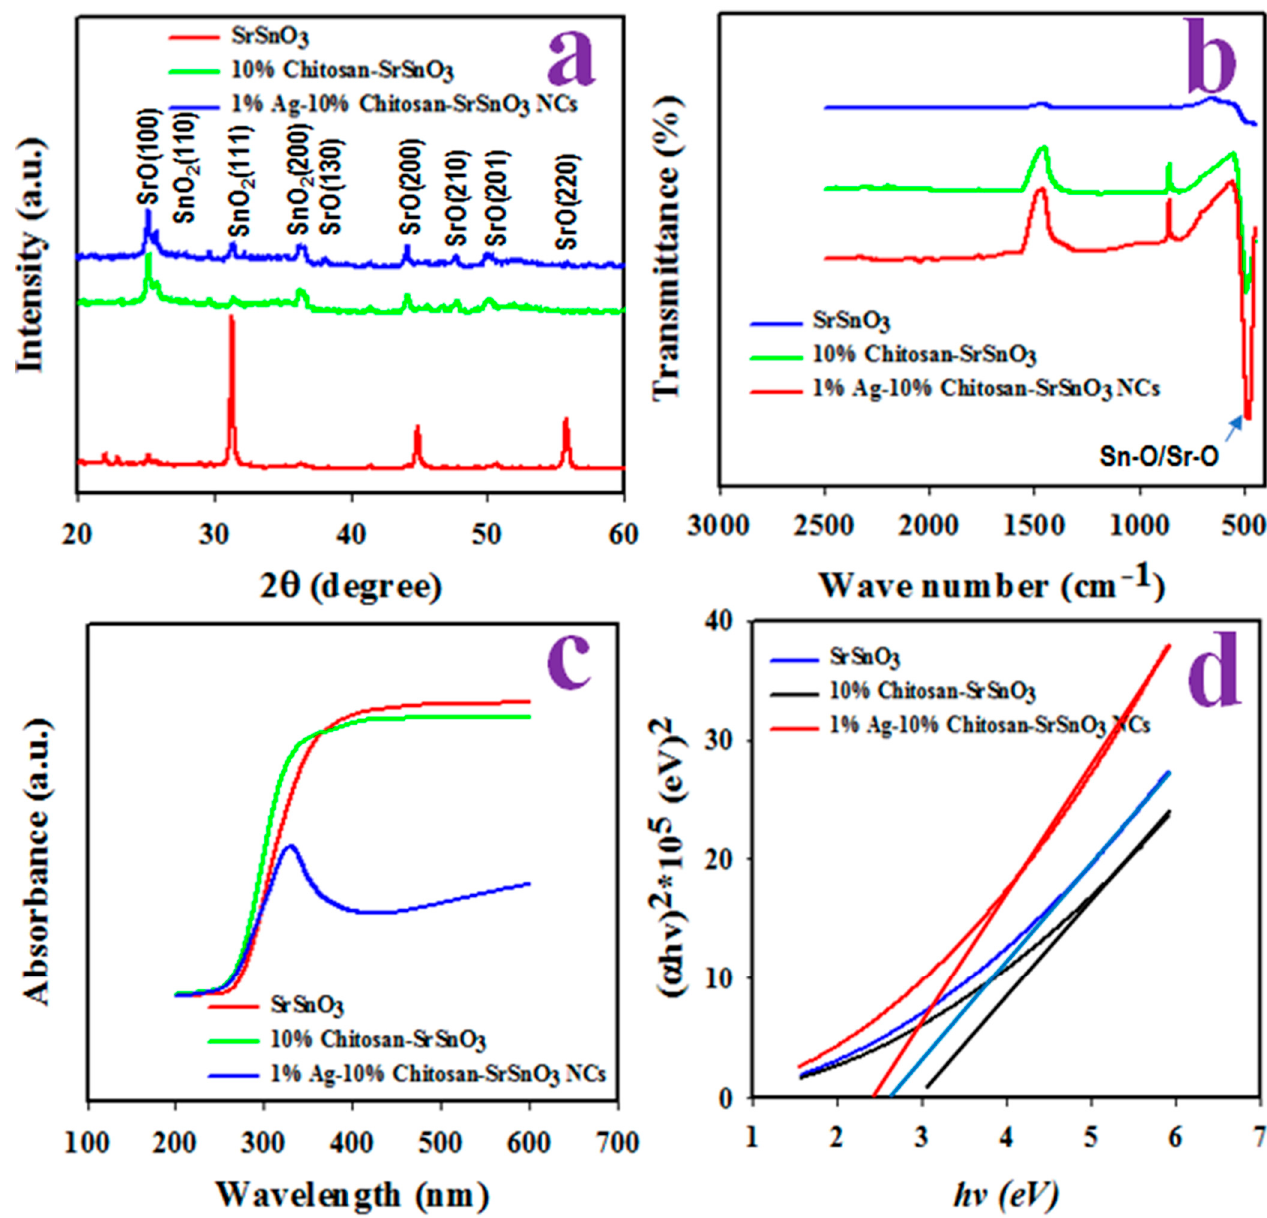
Figure 6. Structural and optical characterizations of Ag-decorated Chitosan/SrSnO 3 NCs: ( a ) Powder XRD pattern, ( b ) FTIR, and ( c , d ) UV-vis optical absorbance.